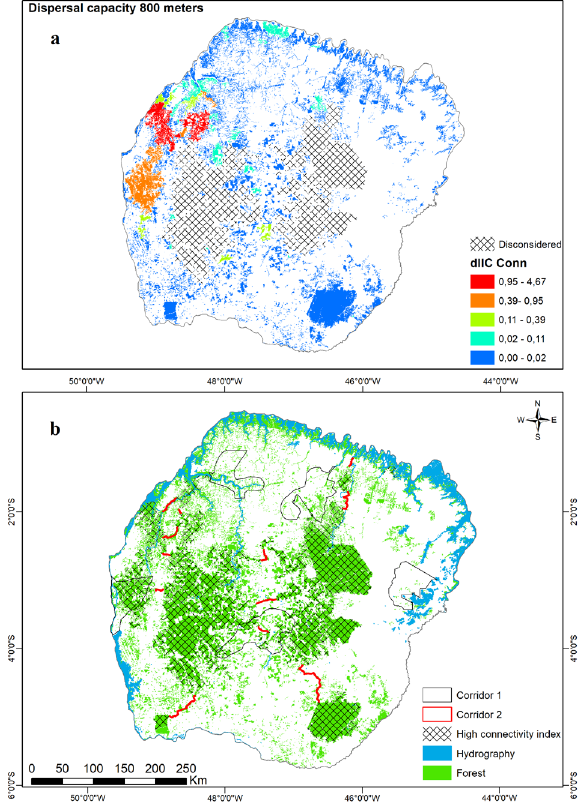
Figure 5. (a) classification of fragments in an alternative scenario in which the two largest fragments were excluded. (b) Proposals to create an ecological corridor: developed by the Brazilian government (corridor 1); and that developed in our research (corridor